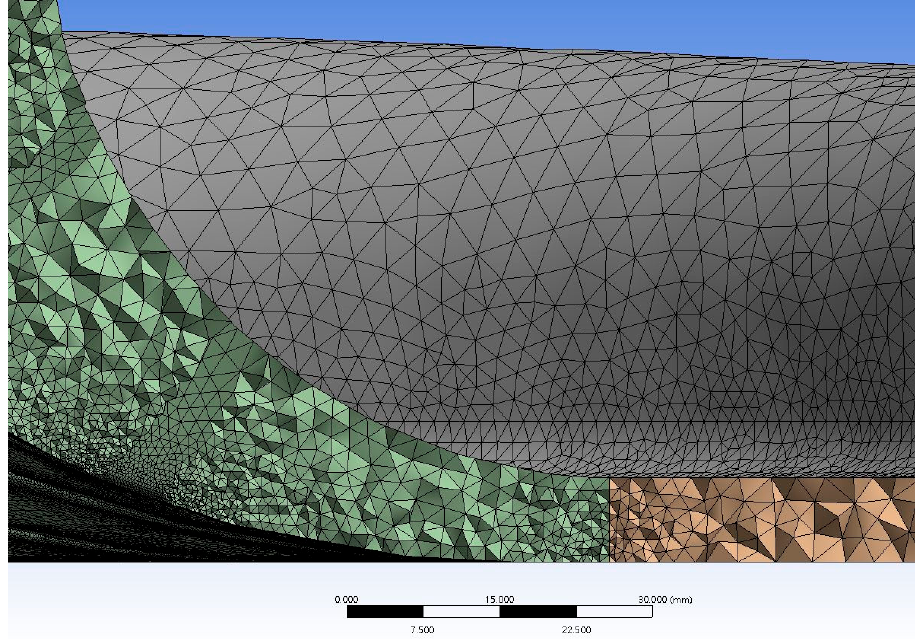
Figure 7. Joint of impeller and diffuser of mesh .